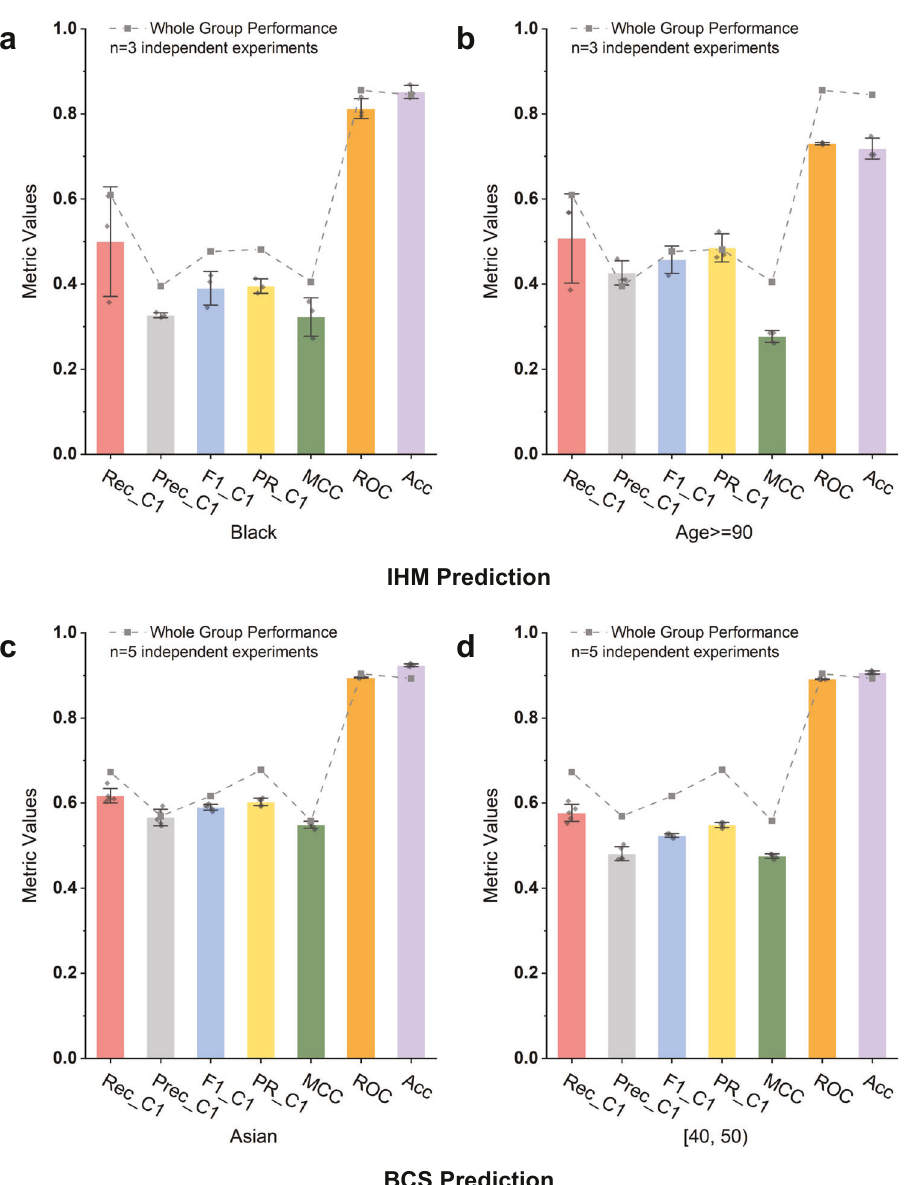
Fig. 4 Comparison of whole-population metrics with minority class-speci fi c metrics. Some whole-population metrics (e.g., AUC-ROC and accuracy) are misleading for the minority class. These deceptive metrics show high values, whereas the prediction is weak for the minority class. a Black subgroup performance for IHM prediction. b Age ≥ 90 subgroup performance for IHM prediction. c Asian subgroup performance for BCS prediction. d Age [40, 50) subgroup performance for BCS